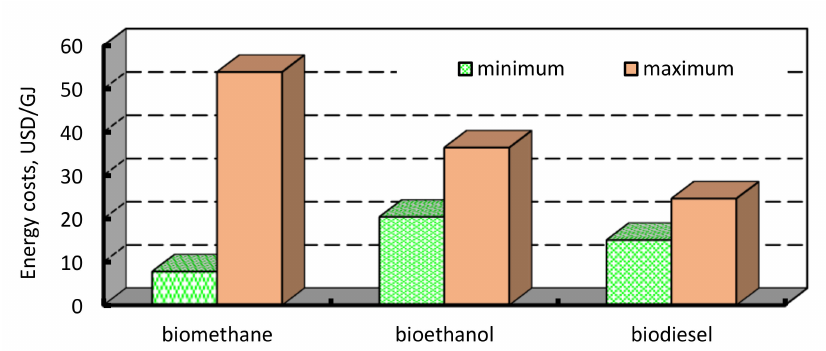
Figure 11. Biomethane production costs.